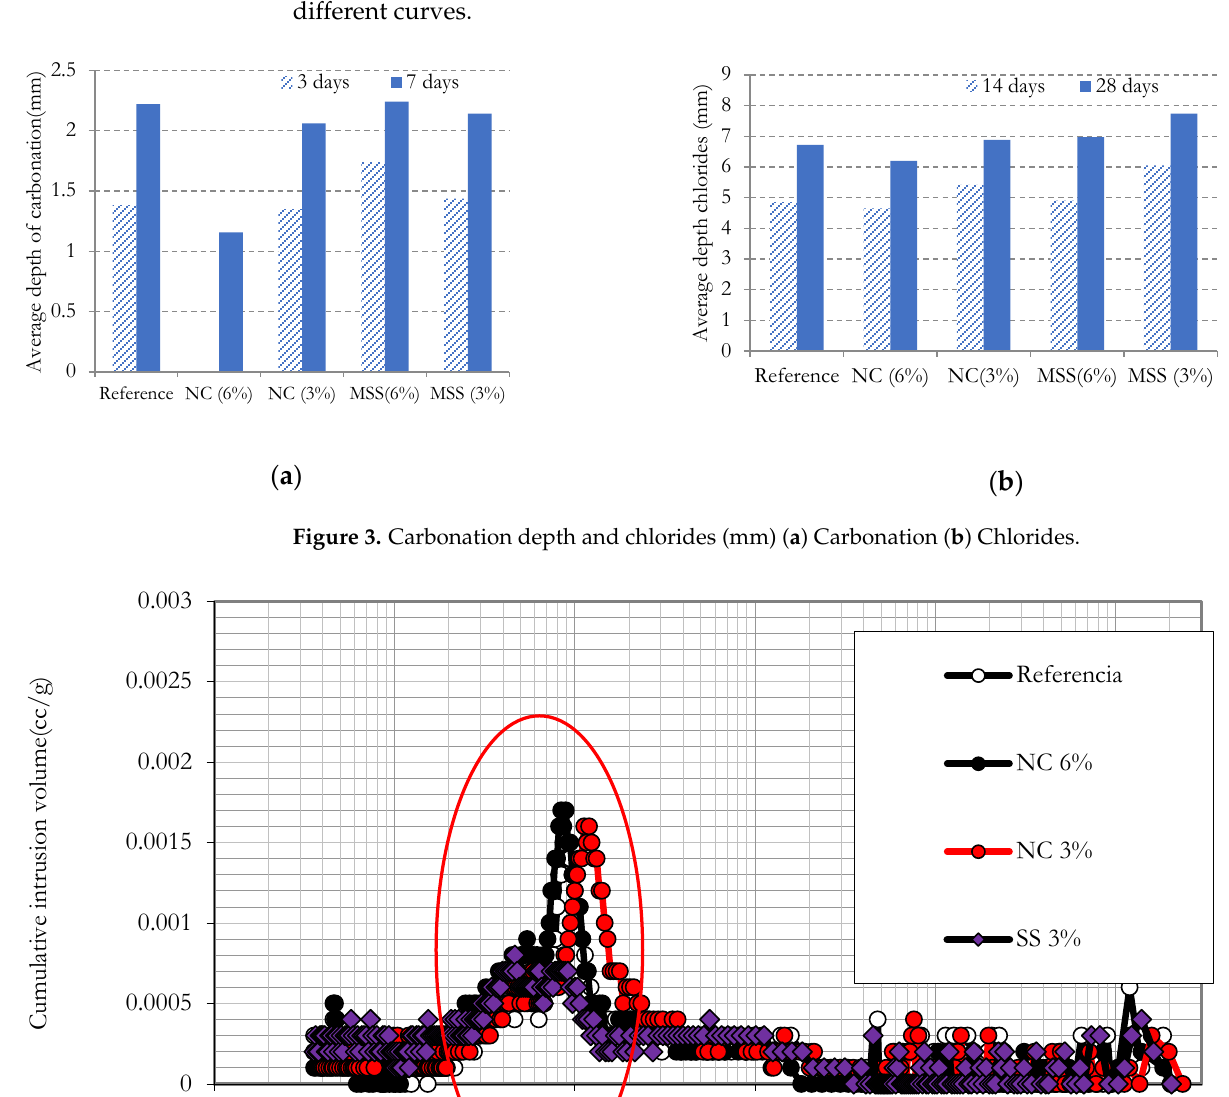
Figure 4. Mercury intrusion volume (cc/g).